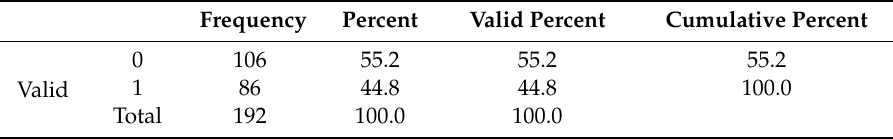
Table 17. Frequency table: I can never think of sharing my car.